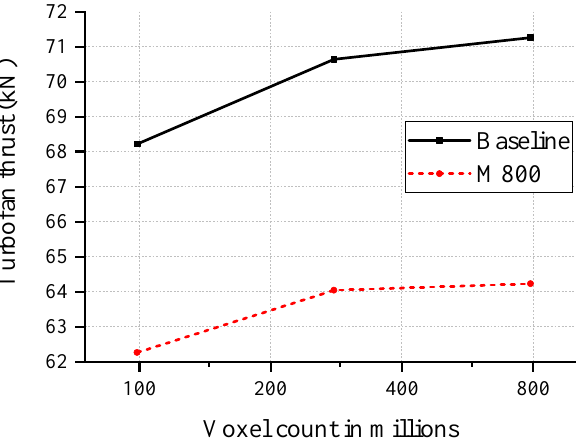
Figure 5. The variation of the thrust produced by the SDT fan stage against the grid resolution